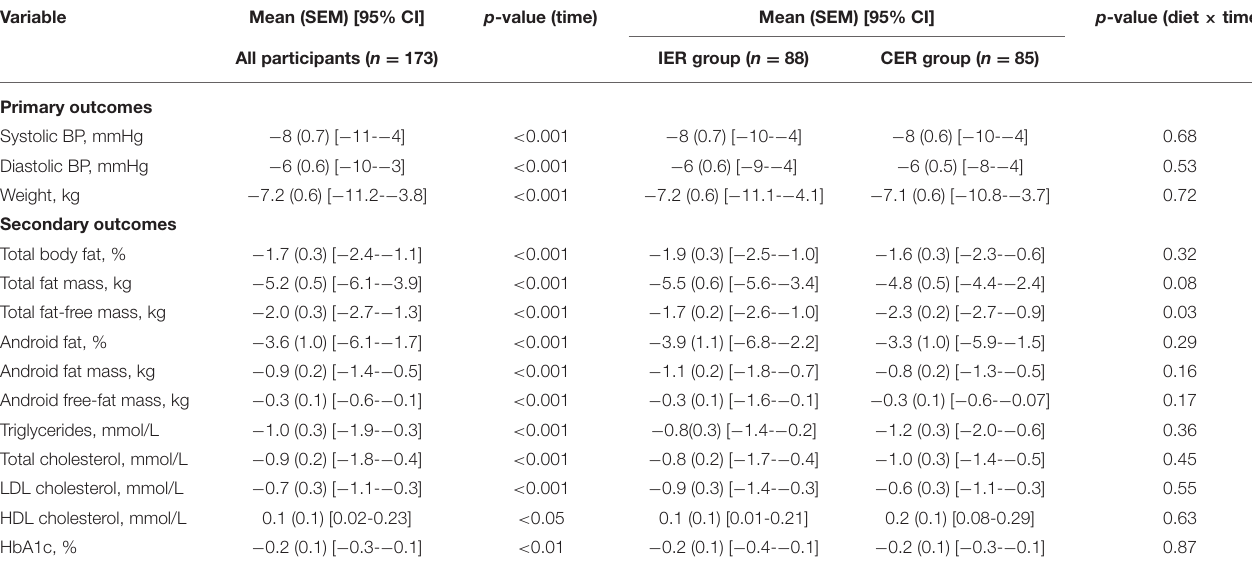
TABLE 2 | Primary and secondary outcomes from baseline to 6 months for IER vs. CER groups (completers analysis). Variable